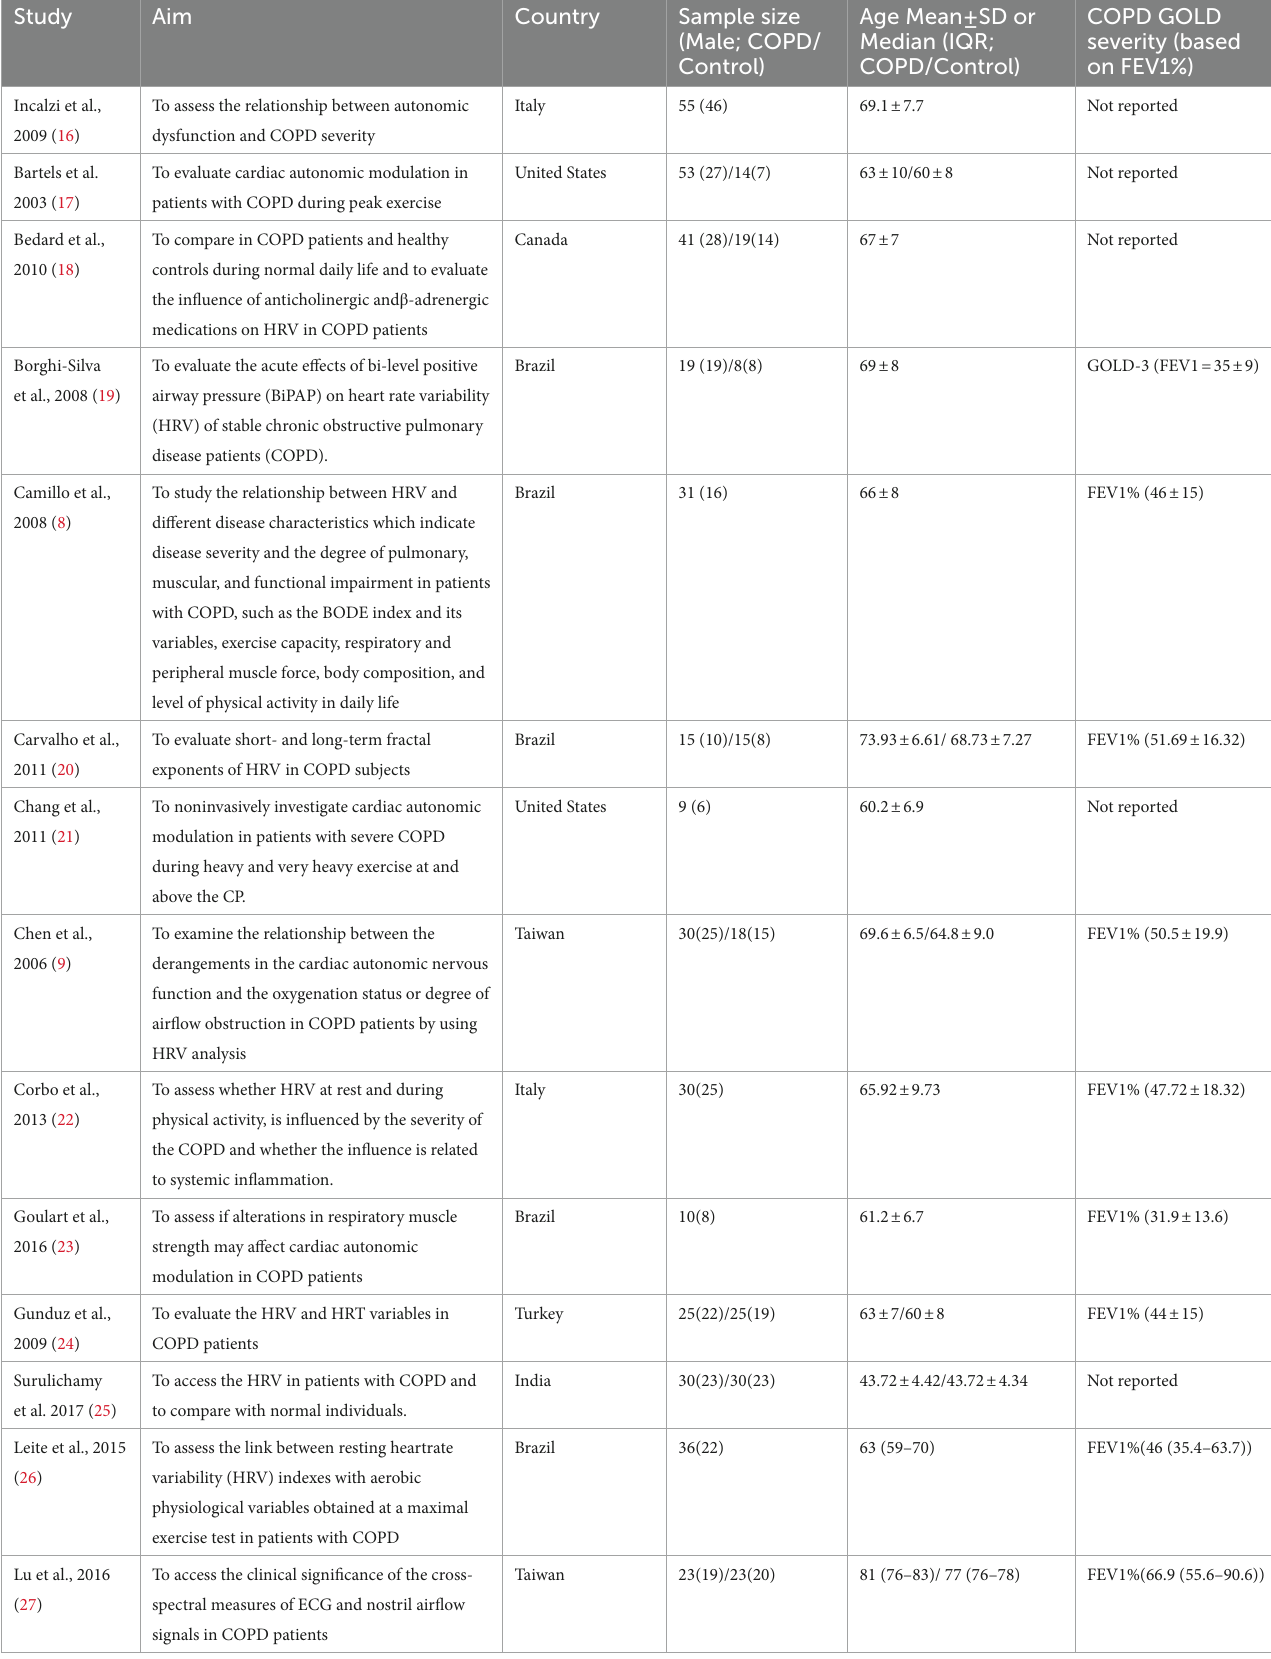
TABLE 1 ECG recording and HRV analysis techniques of included studies.